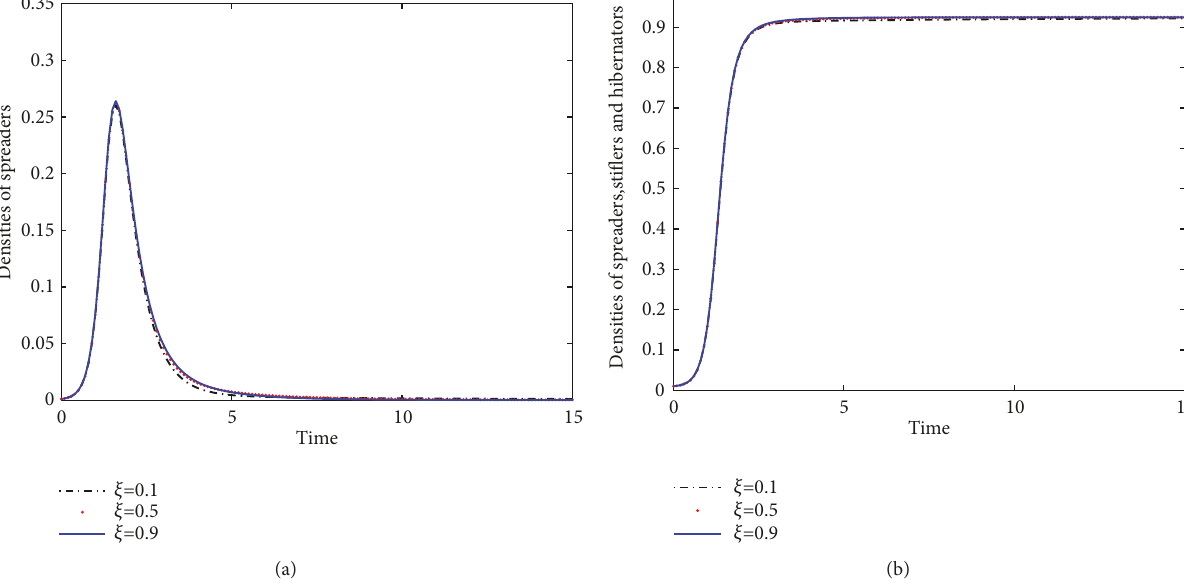
choice of the initial spreader node only affects the spread speed of